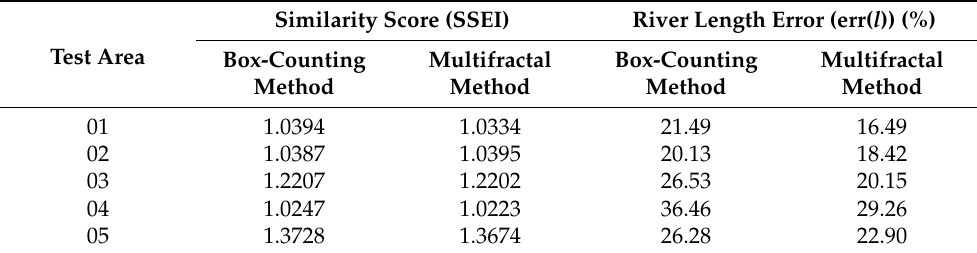
Table 8. Similarity score and river network error corresponding to Hubei test areas obtained with the box-counting and multifractal methods (Hubei